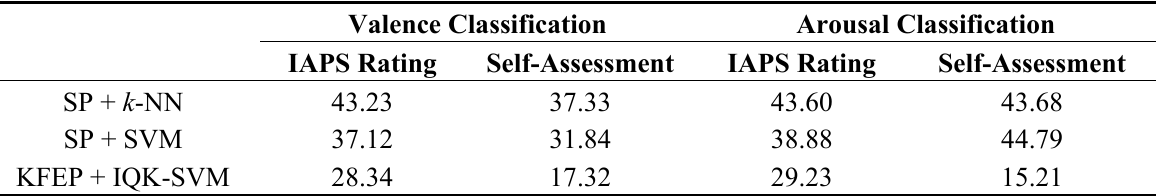
Table 6. Comparison of average error rates (in %) between the classification accuracy based on the IAPS-rating and the self-assessment